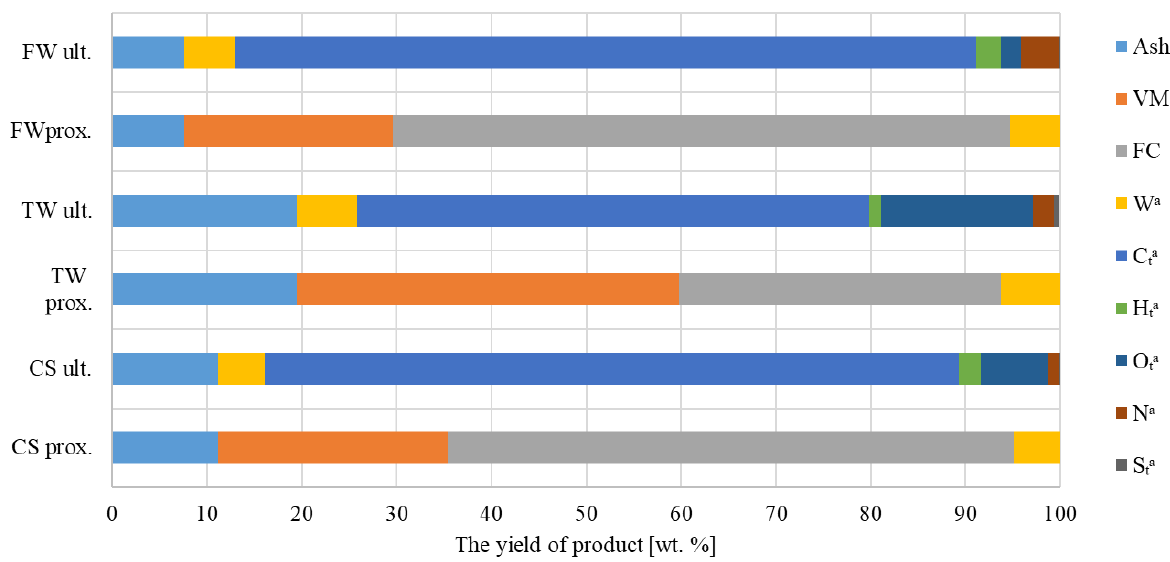
Figure 4. Evaluation of biochar’s potential and its ultimate significance (t—total, e.g., total carbon, and a—in the analytical state, i.e., the sample after crushing, drying, and sieving—ready for analy- sis).